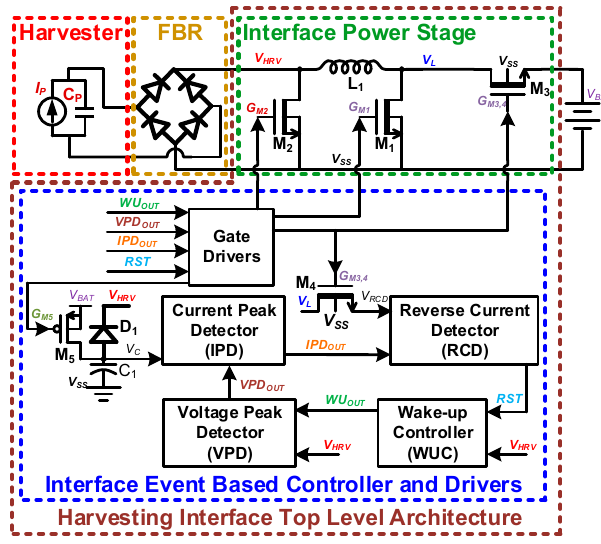
Figure 2. Top level block diagram of the proposed harvesting interface.